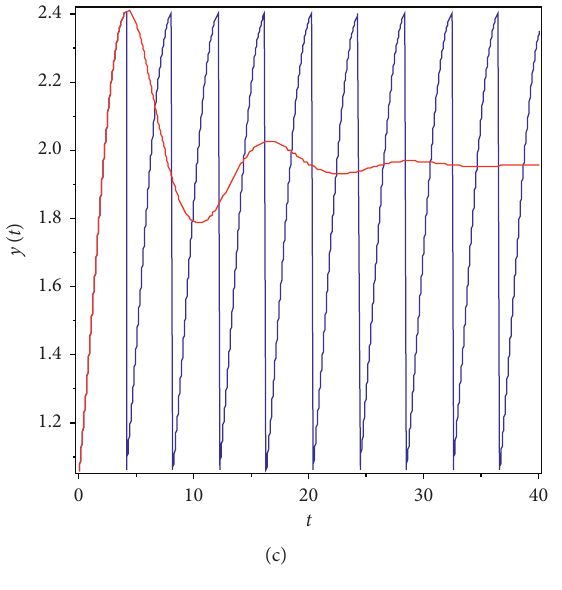
( y ) < y M A A . And the parameters are fixed as